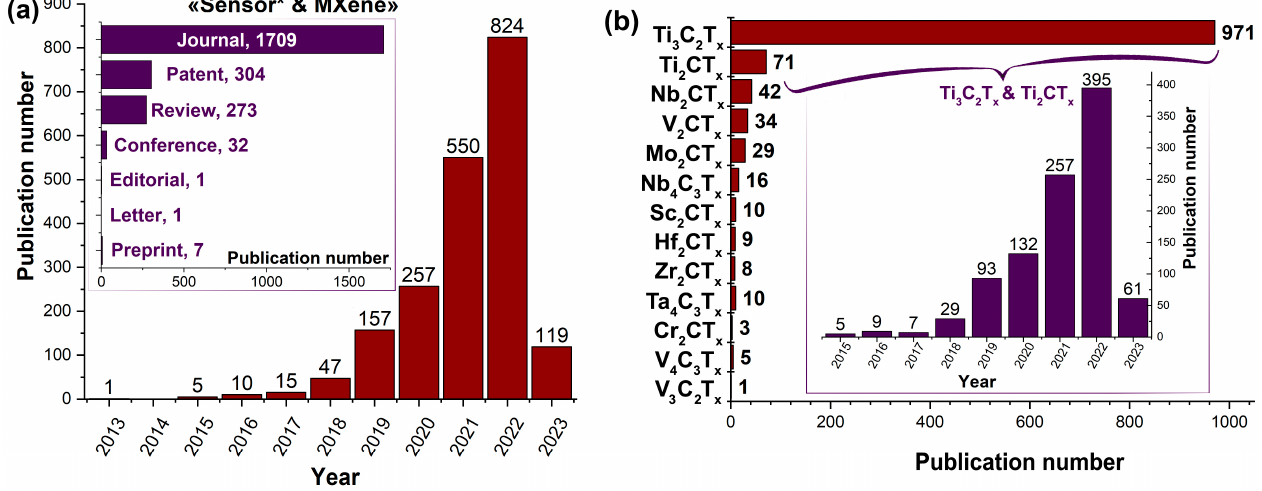
Figure 1. Analysis of reports devoted to MXenes: ( a ) the annual number of publications indexed with keywords “Sensor* and MXene”; insert is distribution of publications by type; ( b ) distribution of articles depending on the kind of MXene; insert is annual number of publications indexed for Ti 3 C 2 T x and Ti 2 CT x . The data were taken with CAS, SciFinder n (September